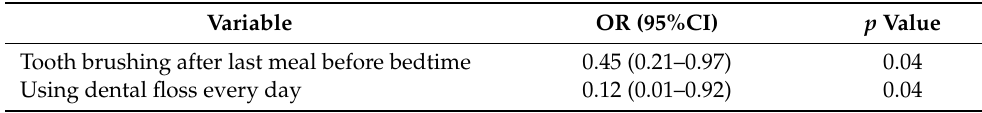
Table 5. Logistic regression model describing the predictors of “higher” caries experience (DMFT > 5) among the examined 15-year-old teenagers in Szczecin. Variable OR